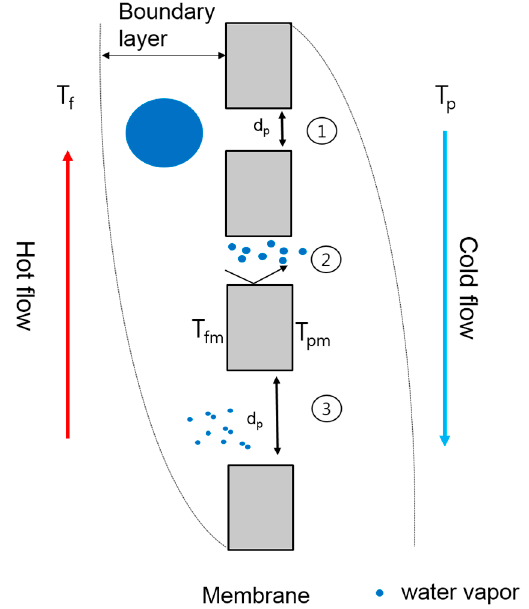
Figure 1. Basic principles of direct contact membrane distillation (DCMD) process.